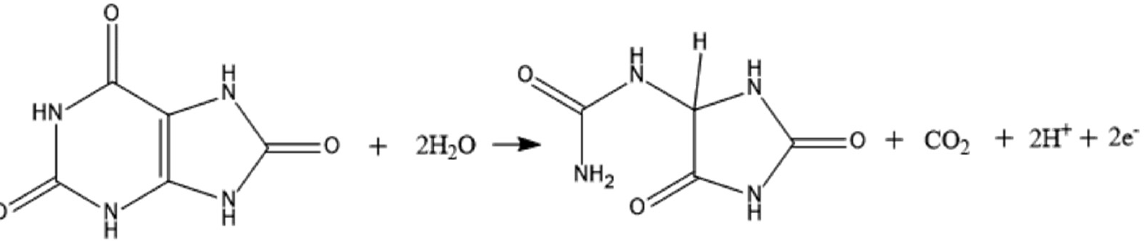
Figure 6. The proposed electrochemical oxidation of uric acid.